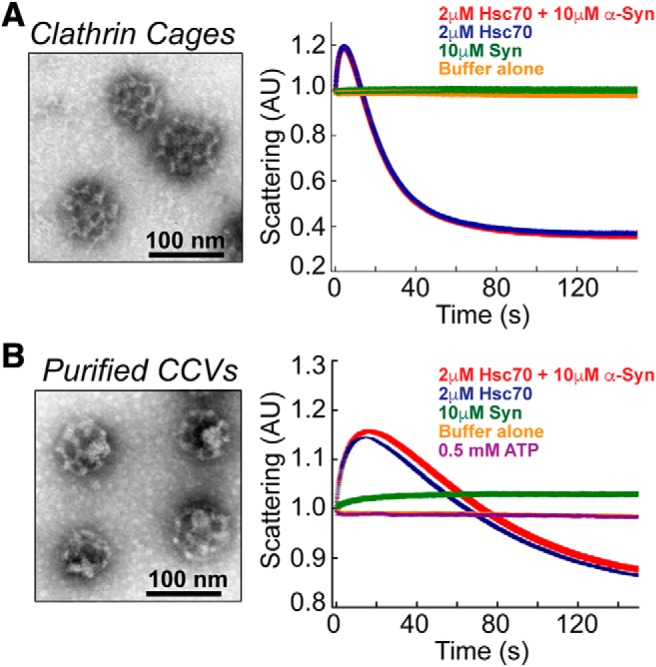
α-Synuclein does not affect Hsc70-mediated clathrin disassembly in vitro. A, left, Clathrin cages were assembled in vitro using recombinant clathrin heavy chain and auxilin, as described in Sousa et al. (2016). Right, An in vitro light scattering assay showed that addition of 2 μM Hsc70 exponentially reduced the light scattering intensity as clathrin cages were disassembled (blue trace). Addition of 10 μM α-synuclein did not alter the rate of Hsc70-mediated clathrin disassembly (red trace). No change in light scattering was observed in baseline control measurements after addition of buffer (yellow trace) or 10 μM α-synuclein alone (green trace). B, left, CCVs, which contain the underlying endocytic vesicle membranes, were freshly purified from bovine brains. Right, α-Synuclein alone slightly increased light scattering (green trace), which is likely due to its binding to the endocytic vesicles. Similar to the results with clathrin cages, introduction of 10 μM α-synuclein did not significantly affect the dynamics of Hsc70-mediated CCV uncoating (blue vs red trace).